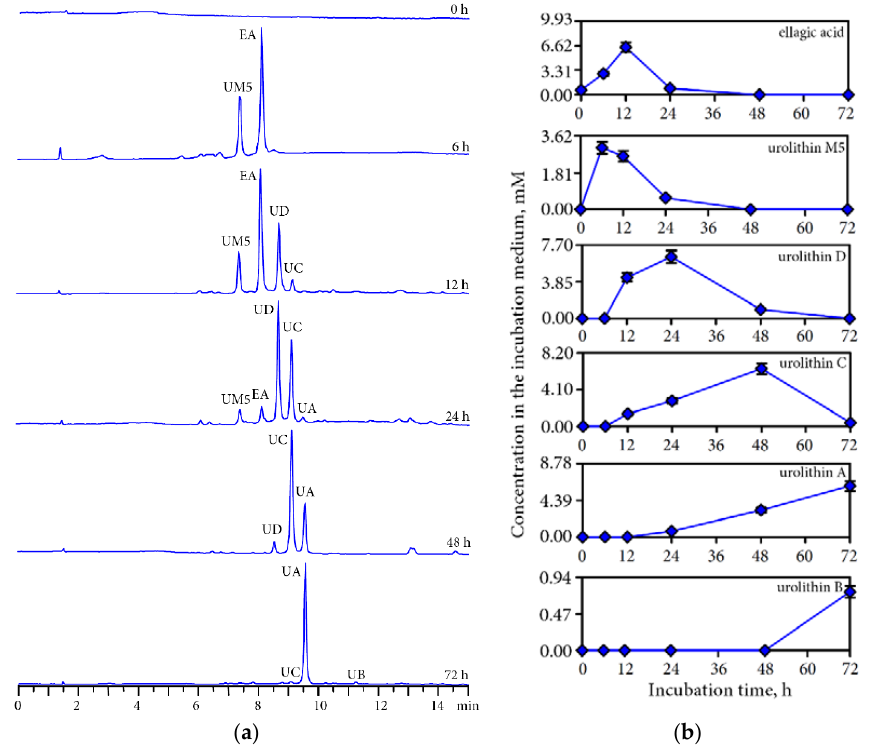
Figure 6. ( a ) HPLC-chromatograms of intestine media retentate after 0–72 h incubation with human gut microbiota; ( b ) Dynamic of content of ellagic acid and urolithins in colonic media.